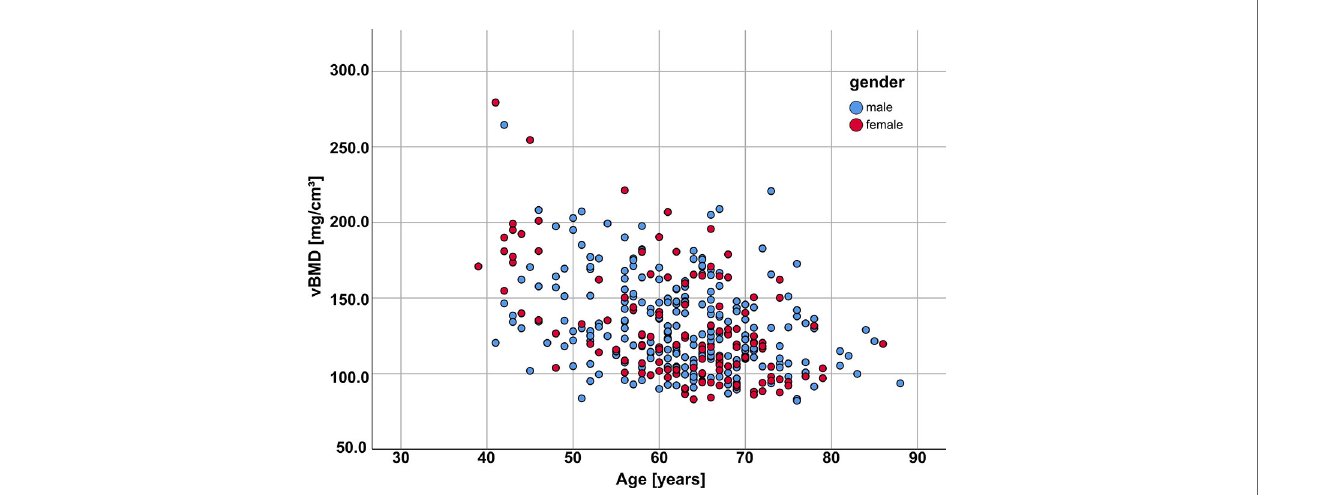
FIGURE 2 | Patient age vs vBMD (averaged across all analyzed vertebrae for each patient) for females (red) and males (blue); vBMD, volumetric bone mineral